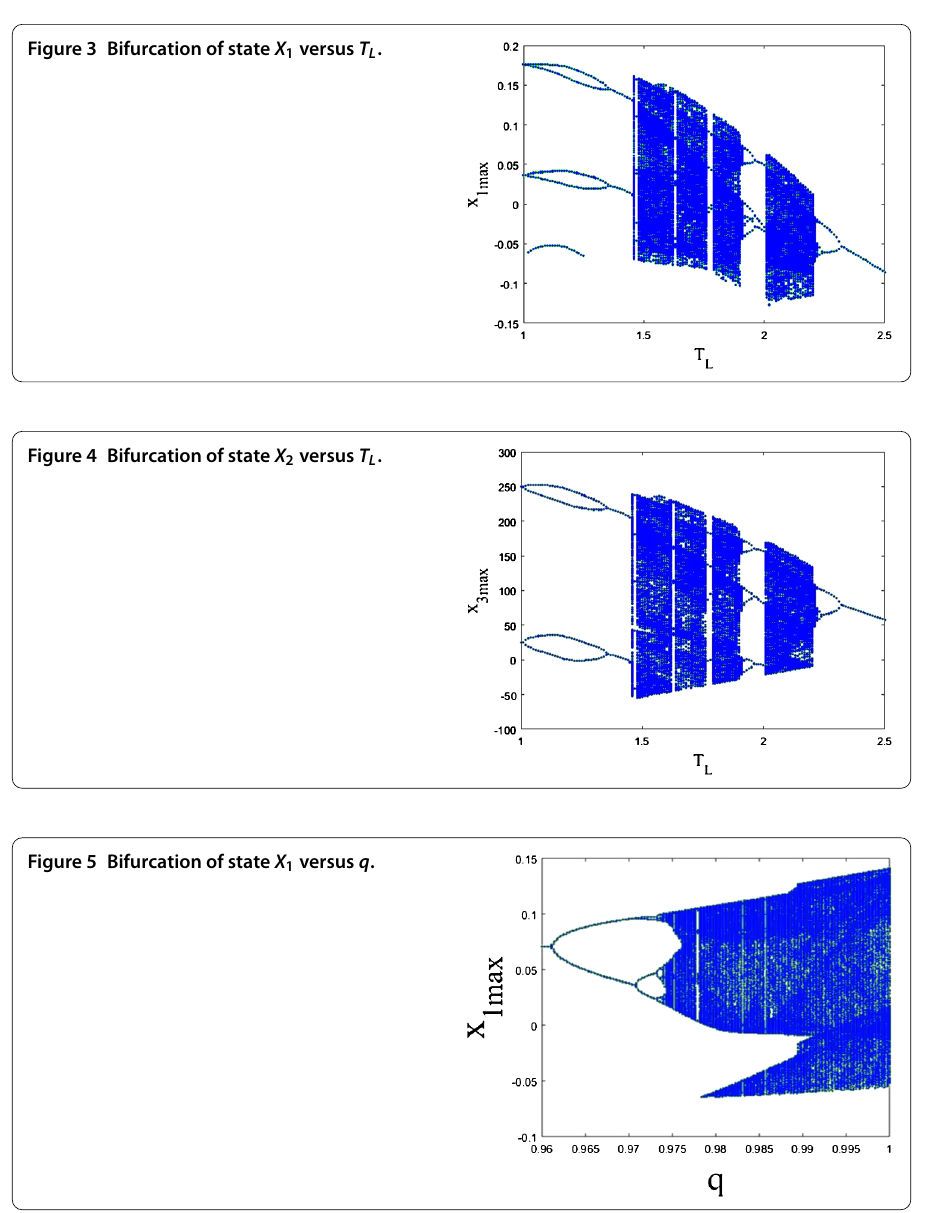
Figure 3 Bifurcation of state X 1 versus T L .